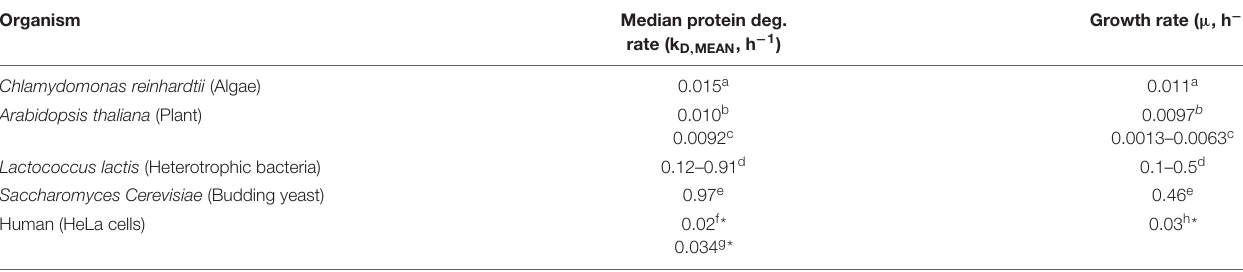
TABLE 1 | Reported median protein degradation rates and growth rates in different organisms.